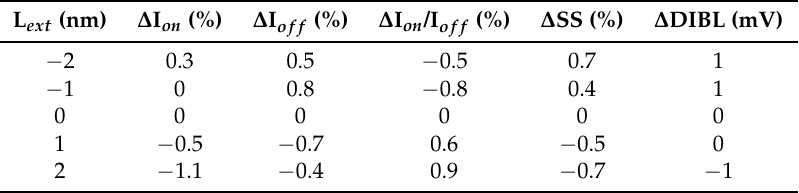
Table 3. Impact of Core–Insulator Length on Device Performance.